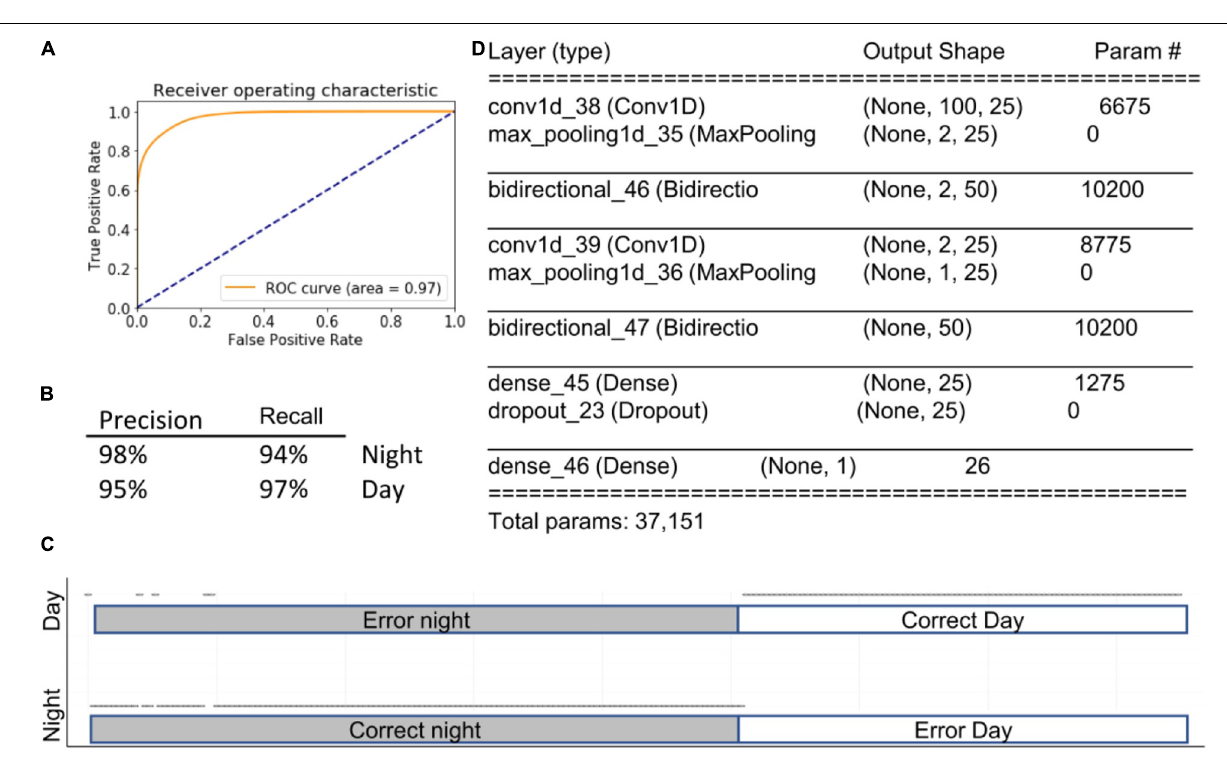
FIGURE 7 | 1DConvBiLSTM. Inserts show ROC curve (A) , accuracy metrics (B) , confusion matrix (C) , and summary of the model (D) . Open circles represent predictions. The majority of prediction are correct, and therefore circles overlap into apparent lines. Dots above marked bars represent incorrect